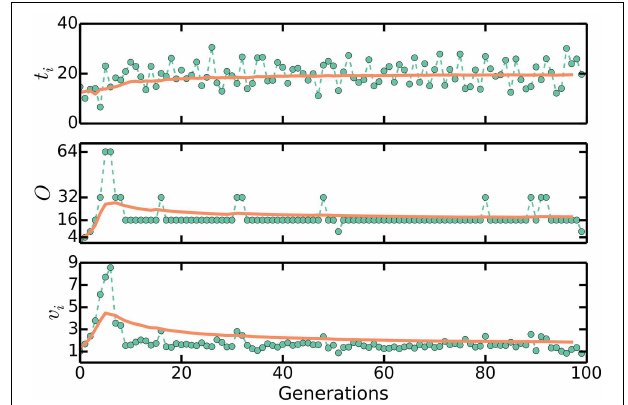
FIGURE 3 | t i , O , and v b approaching stationary distributions in numerical simulations of the multiple origins accumulation model. First, we initialize a population of N cells with uniformly distributed cell ages. Durations between initiations of replication are calculated as Equation (2) and the noise in the initiation process is assumed to be normally distributed. In an initiation event, the number of origins in a cell is doubled. The corresponding division event occurs after a constant time C + D . In a division event, the number of origins in a cell, along with the size of the cell, is halved, and two identical cells are generated. There are no division events without the corresponding initiation events. Following this procedure, a population of cells will robustly reach a stationary distribution of cell sizes and number of origins per cell regardless of initial conditions. The plots here track one lineage of cells. Solid lines are moving averages. Here, C + D = 70 mins , τ = 20 mins , and σ τ = 4 mins . These are biologically realistic choices. We set 1 = 1 / 2 ( C + D ) /τ so that